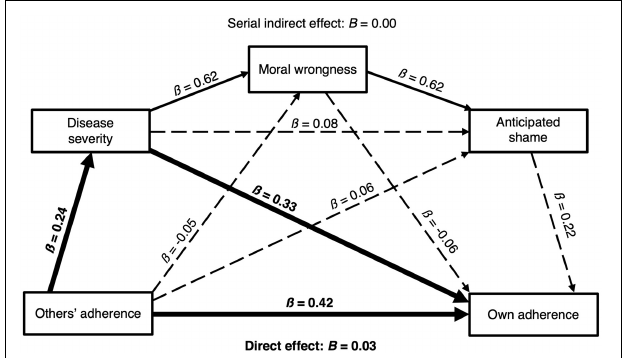
FIGURE 4 | Alternative serial mediation model. Solid lines indicate significant ( p < 0.05) coefficients. Dashed lines indicate non-significant coefficients. Bolded lines indicate the significant pathways to individuals’ adherence to social distancing